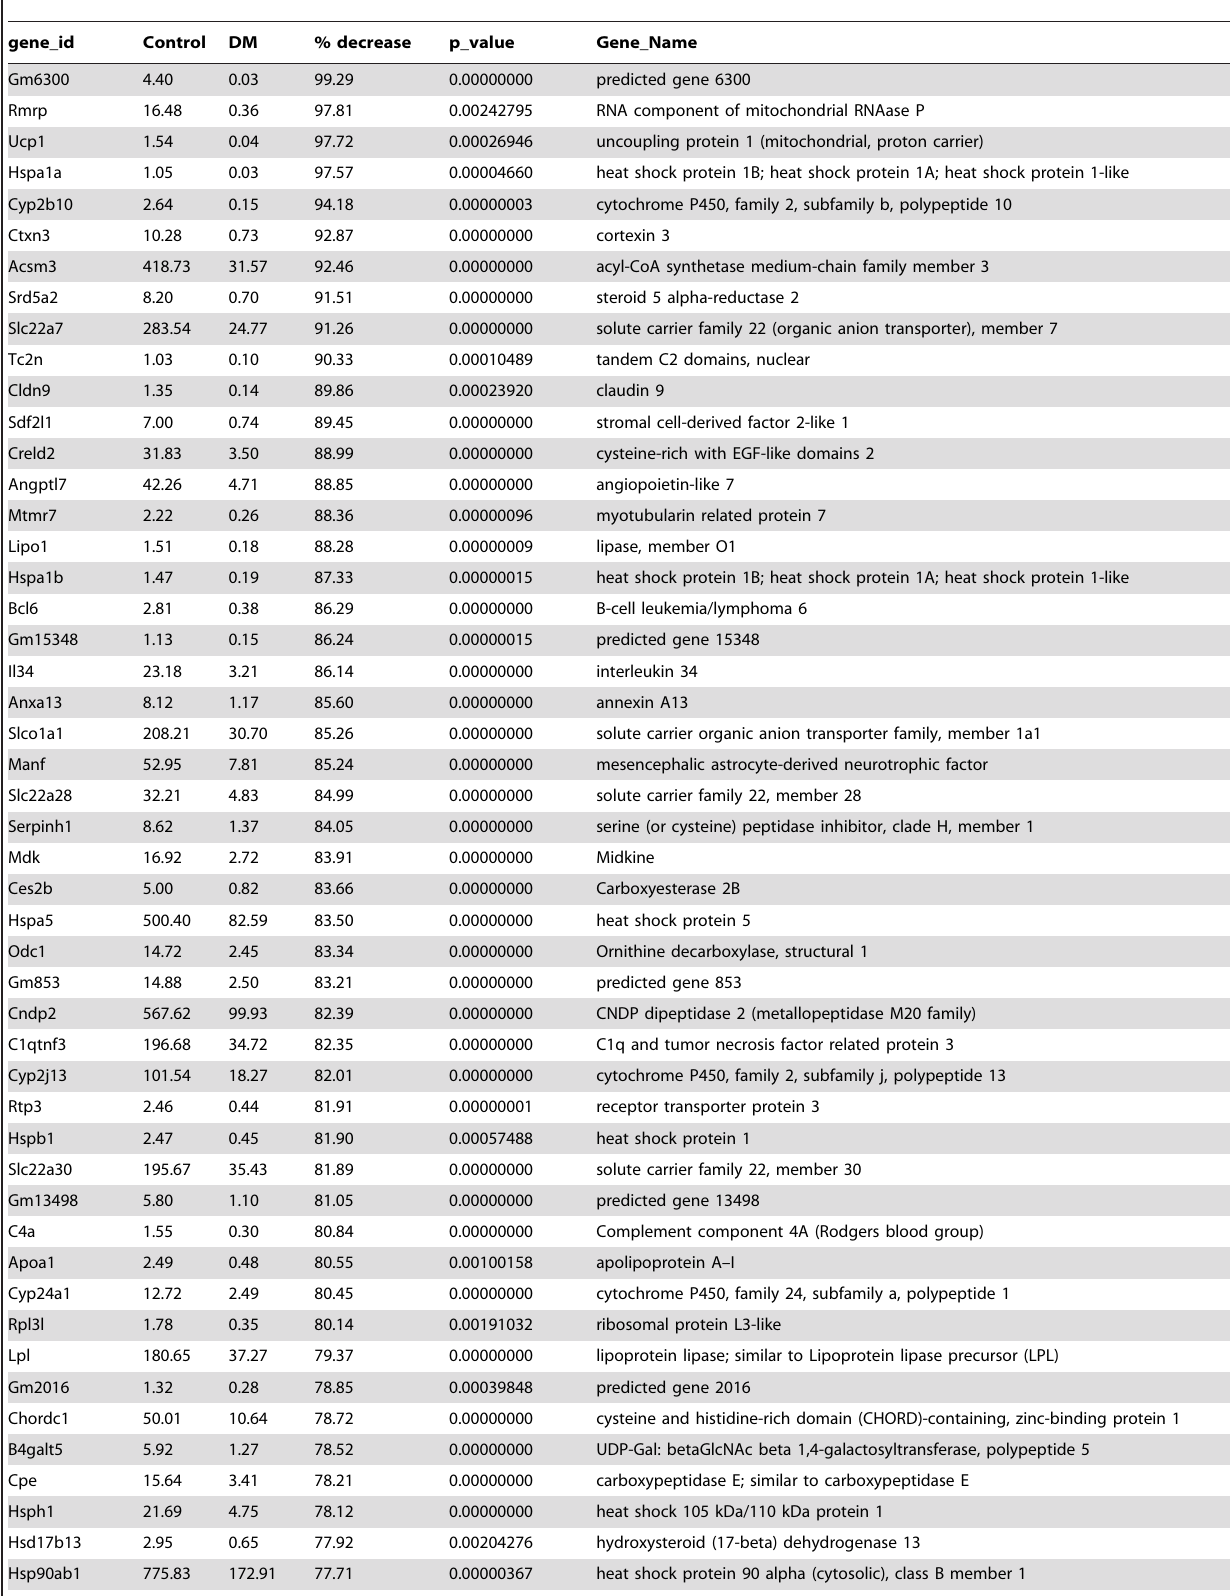
Table 3. All genes exhibiting significantly DOWNregulated ( . 75%) renal expression with diabetes (OVE26) relative to control (FVB)